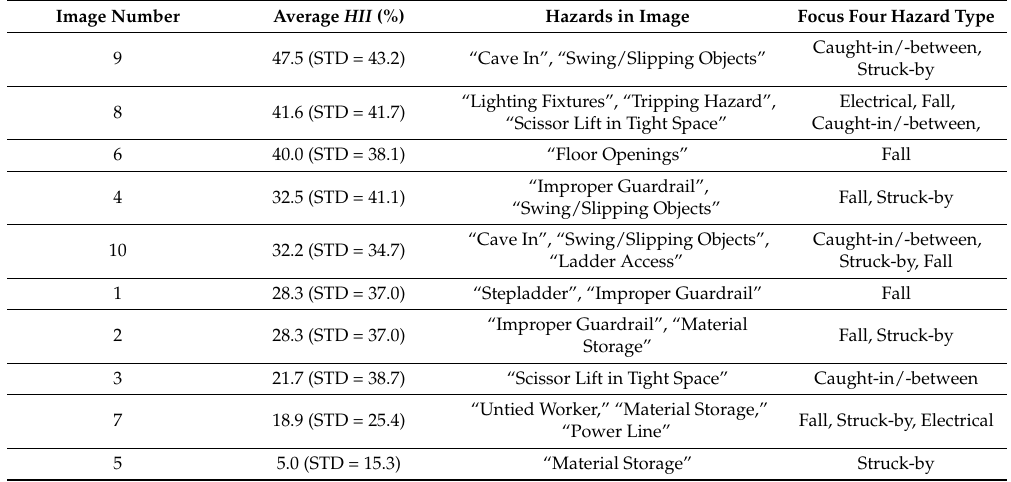
Table 9. Focus Four Hazard by HII and Image